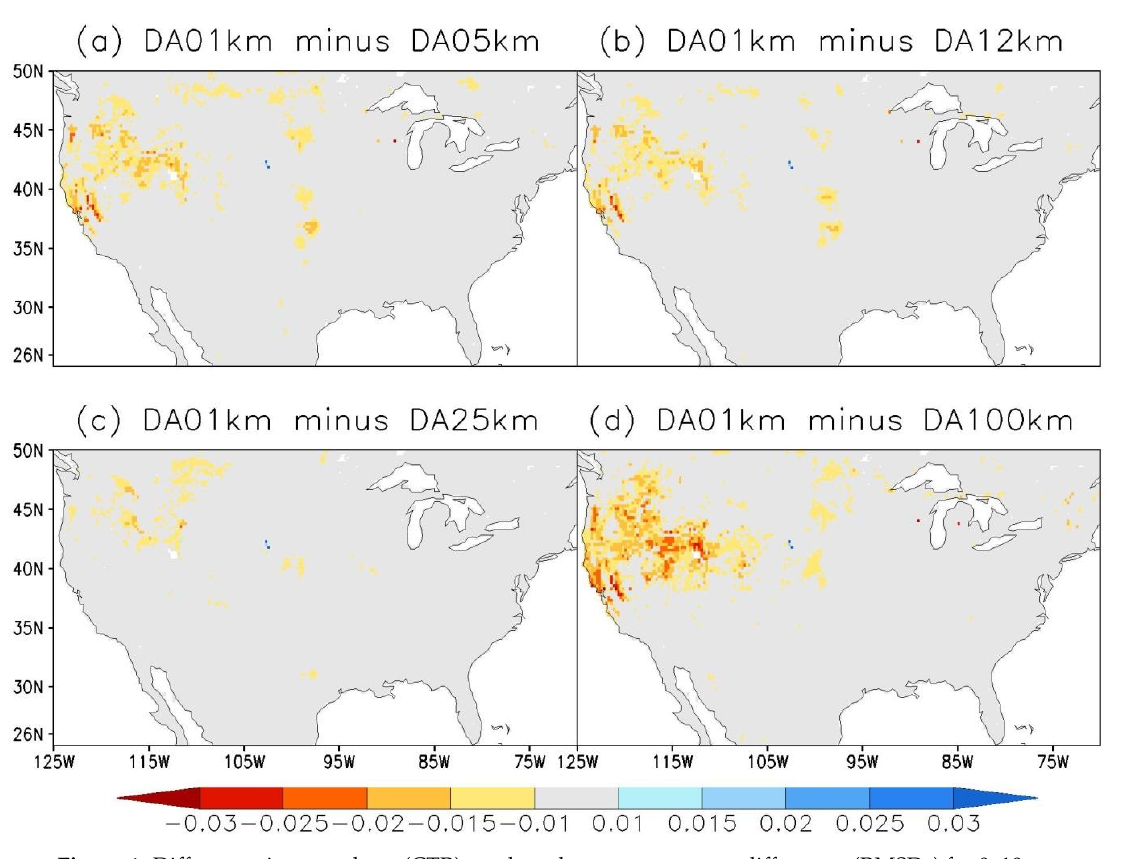
Figure 1. Differences in control run (CTR) run-based root mean square differences (RMSDs) for 0–10 cm soil moisture (SM) simulations during 2015 to 2018 period: ( a ) DA01km Minus DA05km, ( b ) DA01km Minus DA12km, ( c ) DA01km Minus DA25km, and ( d ) DA01km Minus DA100km. The red (blue) color indicates DA01km case performs better (worse), while grey color means insignificant.